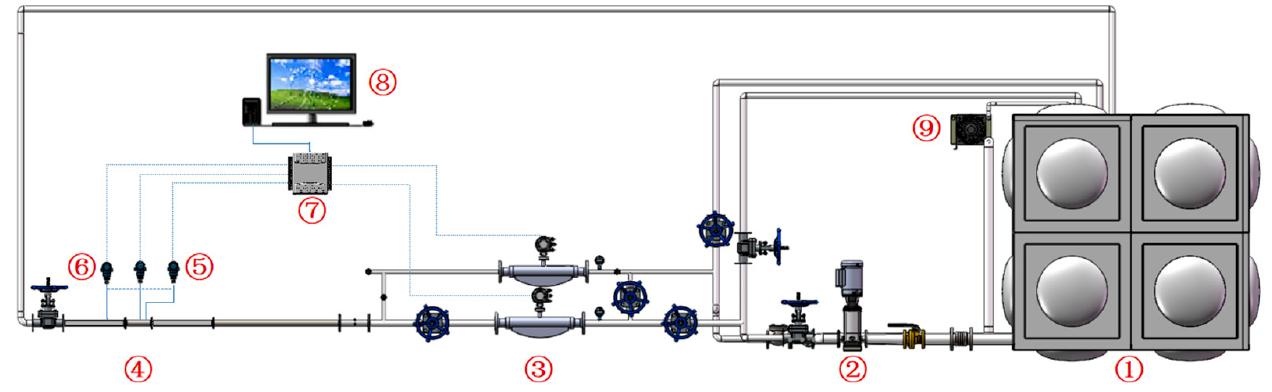
Figure 4. Flow chart of experimental system: ① water tank, ② centrifugal pump, ③ Coriolis mass flowmeter, ④ HAMP test section, ⑤ pressure sensor, ⑥ differential pressure sensor, ⑦ data ac ‐ quisition device, ⑧ computer, ⑨ heat exchanger.